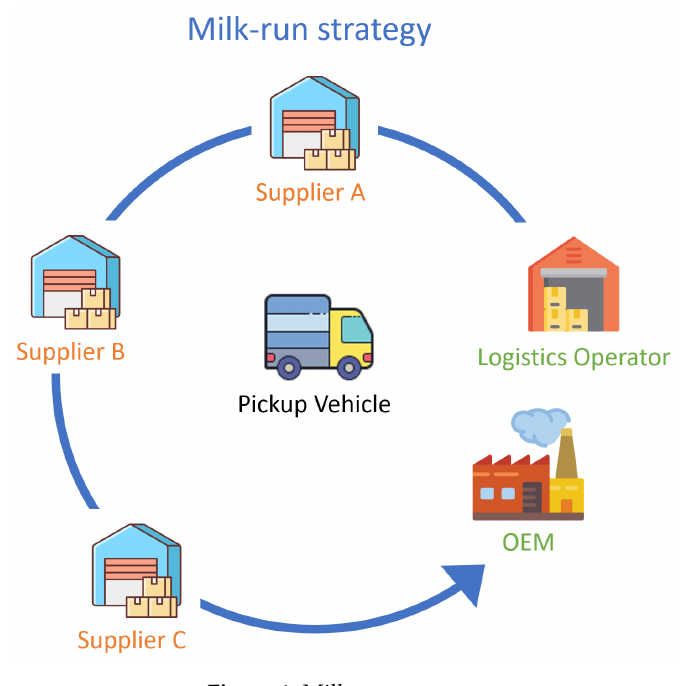
Figure 1. Milk-run